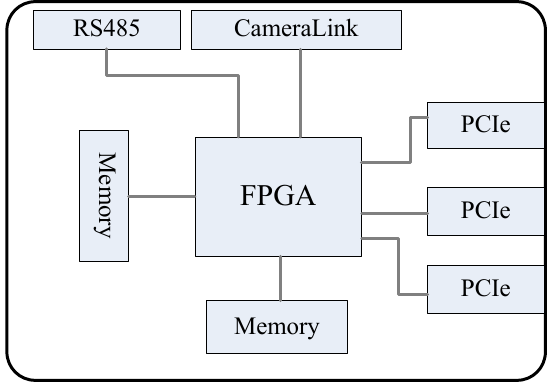
Figure 1. Diagram of data transmission